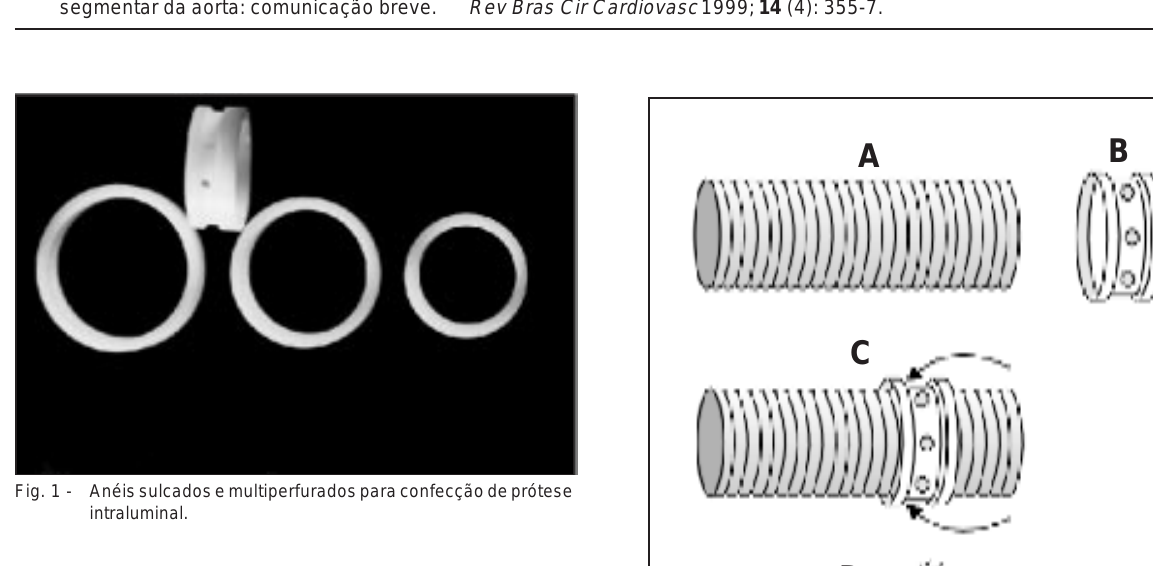
A Figura 2 apresenta as fases de preparo intra-